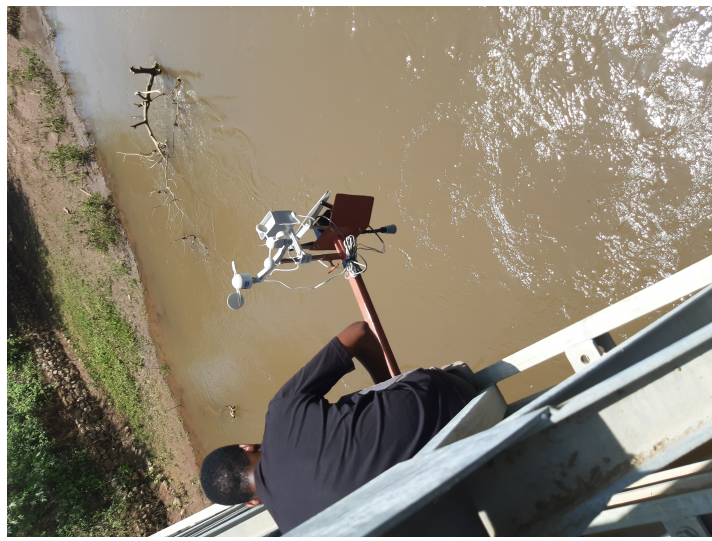
Figure 3. Sensor installation at Kikuletwa